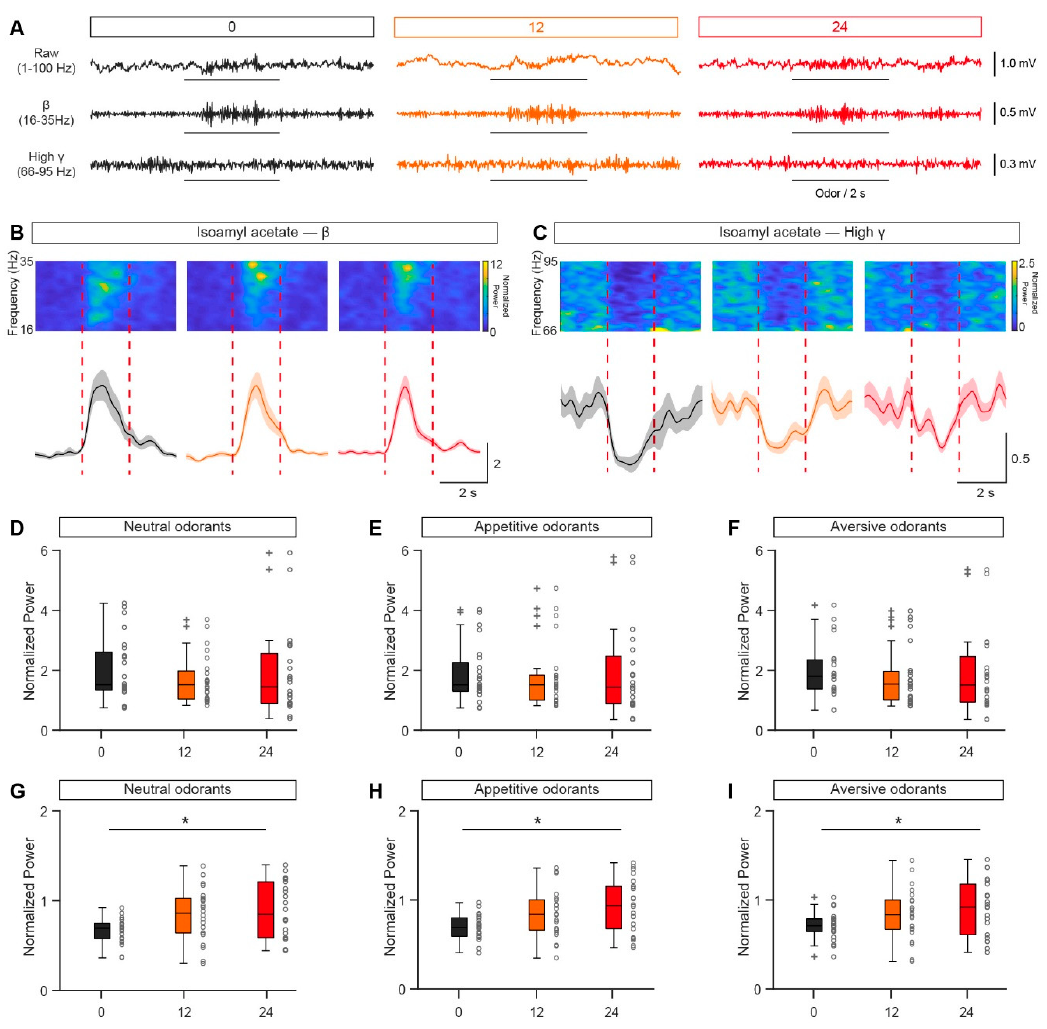
Figure 5. Nutritional status modulates odor-evoked LFP responses. ( A ) Responses of the raw LFP trace and the filtered beta and high gamma bands to odor stimulation under different nutritional states. Black bars indicate odor stimulation. ( B,C ) Top: Example power spectra for odor-evoked beta ( B ) and high gamma oscillations in the OB when mice were fasted for 0 h (black), 12 h (orange), or 24 h (red). Bottom: Trial-averaged normalized traces of odor-evoked beta ( B ) and high gamma ( C ) responses. The red dotted lines indicate the period of odor stimulation. Error bars show the SEM. ( D– F ) Comparison of the power in the normalized odor-evoked beta band evoked by neutral ( D ), appetitive ( E ), or aversive odorants ( F ) under different fasting states (n = 12, neutral odorants, Friedman’s test: χ 2 (2,46) = 1, p = 0.61; appetitive odorants, Friedman’s test: χ 2 (2,46) = 0.58, p =